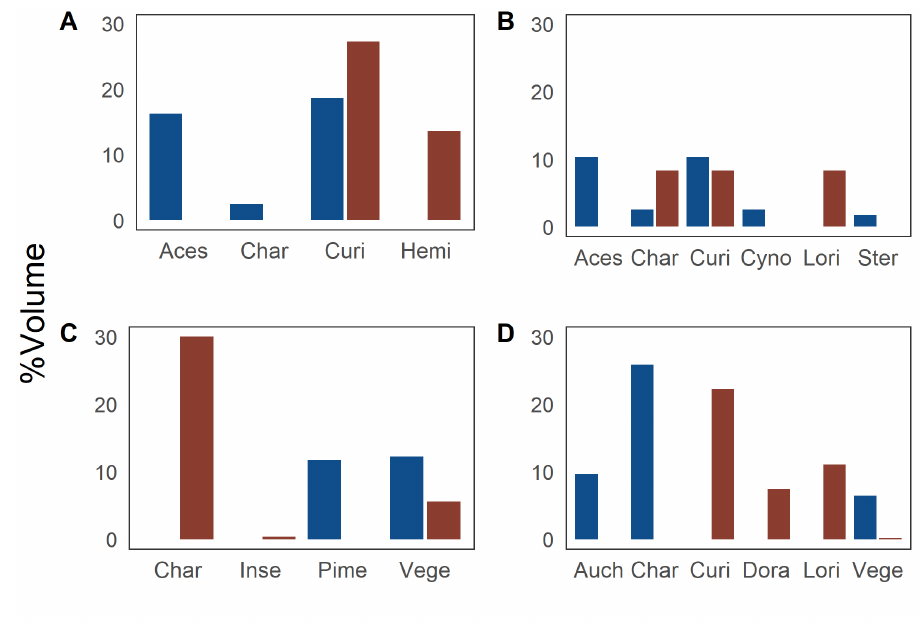
FIGURE 2 | The percent volume of prey consumed by four piscivorous fishes in Madeira River. A. Acestrorhynchus falcirostris , B. Acestrorhynchus heterolepis , C. Hydrolycus scomberoides , and D. Rhaphiodon vulpinus . Blue bars correspond to the pre-damming period and red bars to the post-damming period. Items are Aces = Acestrorhynchidae, Cyno = Cynodontidae, Char = Characidae, Curi = Curimatidae, Ster = Sternopygidae, Hemi = Hemiodontidae, Lori = Loricariidae, Auch = Auchenipteridae, Dora = Doradidae, Pime = Pimelodidae, Inse = Insects, Vege =